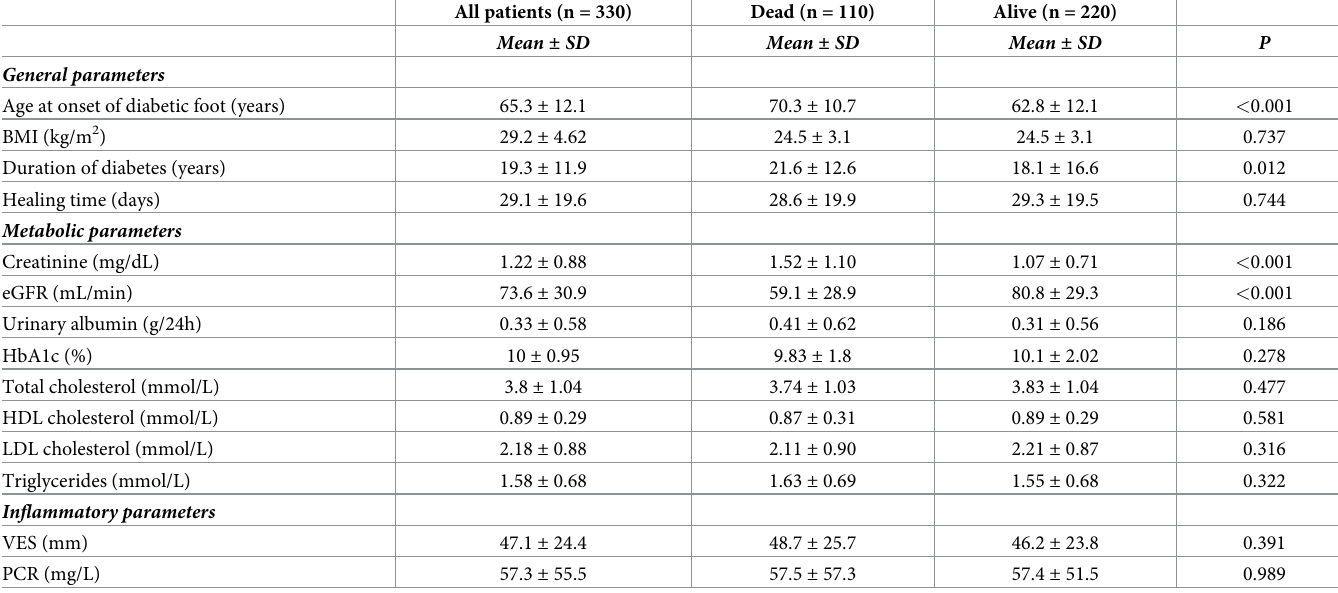
Table 2. Clinical, metabolic and inflammatory parameters in all patients with diabetic foot